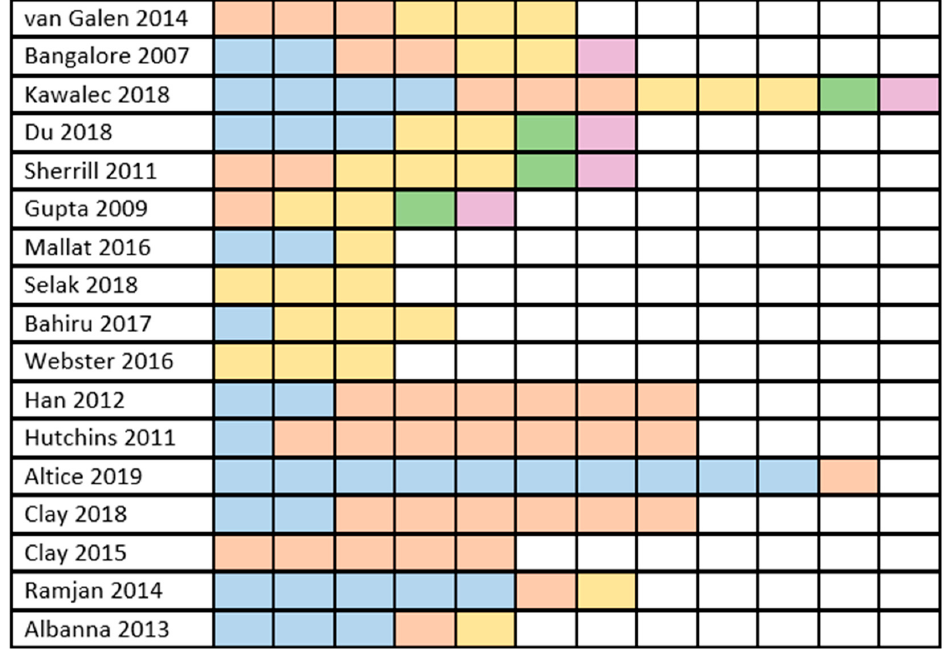
Figure 2. Visual representation of the overlap of the studies included in other systematic reviews and meta-analyses (SR and MA; n = 17). One row represents one SR / MA. Each colored square symbolizes one article, and the number of colored squares is equal to the number of studies included in the corresponding SR / MA. Di ff erent colors represent into how many SRs / MAs an article was included (e.g., if all the colored squares in a row are blue, all the articles are unique to only this SR / MA). Blue: study included only in one SR / MA. Red: study included in two di ff erent SRs / MAs. Yellow: study included in three di ff erent SRs / MAs. Green: study included in four di ff erent SRs / MAs. Purple: study included in five di ff erent SRs / MAs.